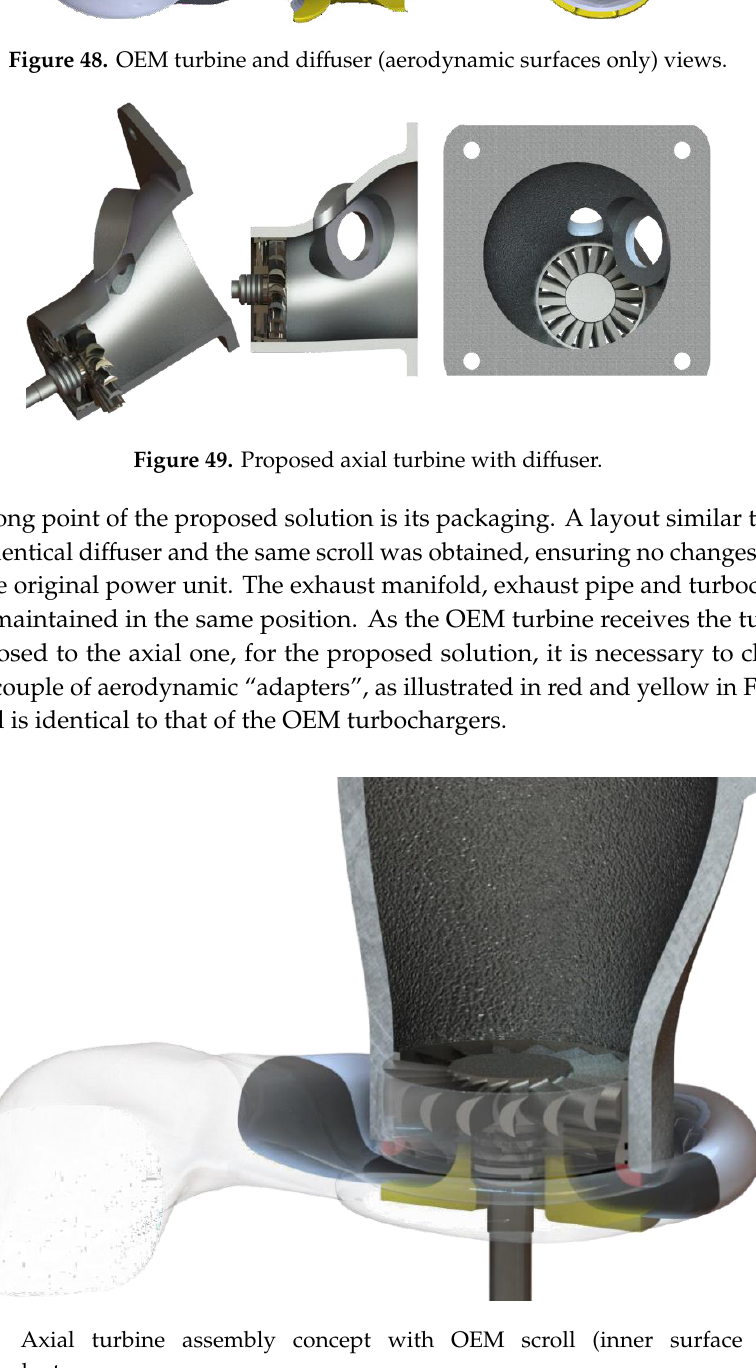
Figure 48. OEM turbine and diffuser (aerodynamic surfaces only) views. Appl. Sci. 2020 , 10 , x FOR PEER REVIEW